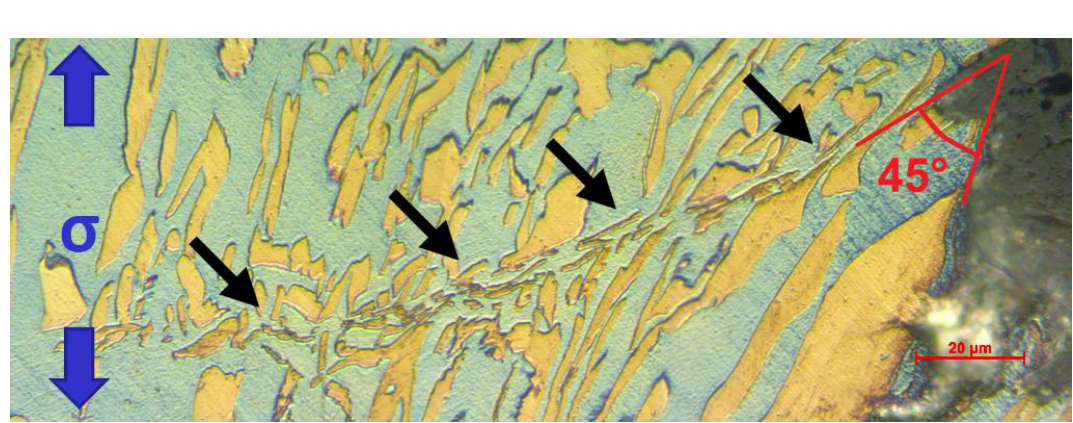
Figure 7. Newly nucleated martensitic shear γ-nuclei along dislocations slip bands and the alignment of these particles to the dislocations structure on the fracture surface section of specimen annealing treated for 355 s/mm at 1353 K (1080 °C), due to the Magee effect.